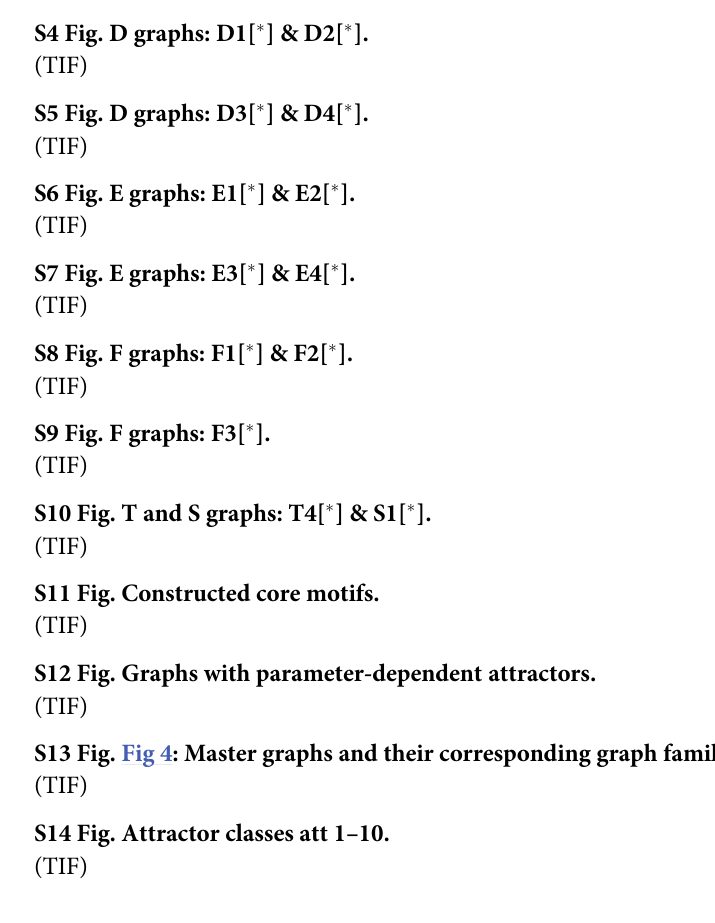
S4 Fig. D graphs: D1[ � ] & D2[ � ]. S5 Fig. D graphs: D3[ � ] & D4[ � ]. S6 Fig. E graphs: E1[ � ] & E2[ � ]. S7 Fig. E graphs: E3[ � ] & E4[ � ]. S8 Fig. F graphs: F1[ � ] & F2[ � ]. S9 Fig. F graphs: F3[ � ]. S10 Fig. T and S graphs: T4[ � ] & S1[ � ]. S11 Fig. Constructed core motifs. S12 Fig. Graphs with parameter-dependent attractors. S13 Fig. Fig 4: Master graphs and their corresponding graph families. S14 Fig. Attractor classes att